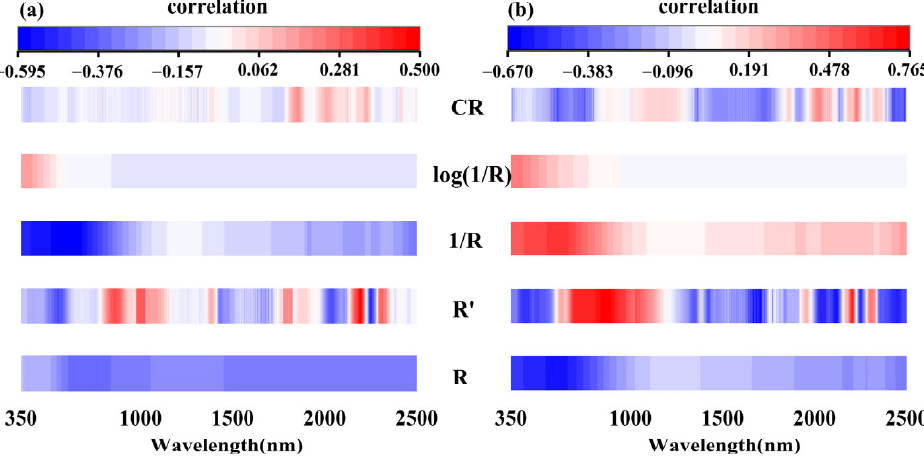
Figure 7. Spectral correlation between SOC and soil. ( a ) silty soil; ( b ) sandy soil.